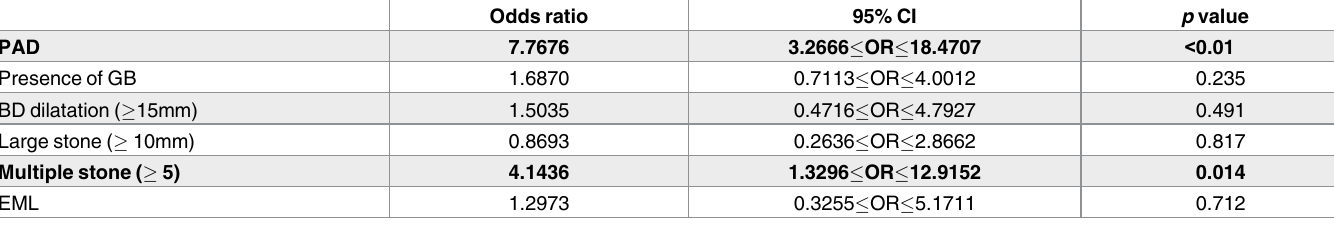
Table 3. Multivariate analysis for stone recurrence(Logistic regression test).